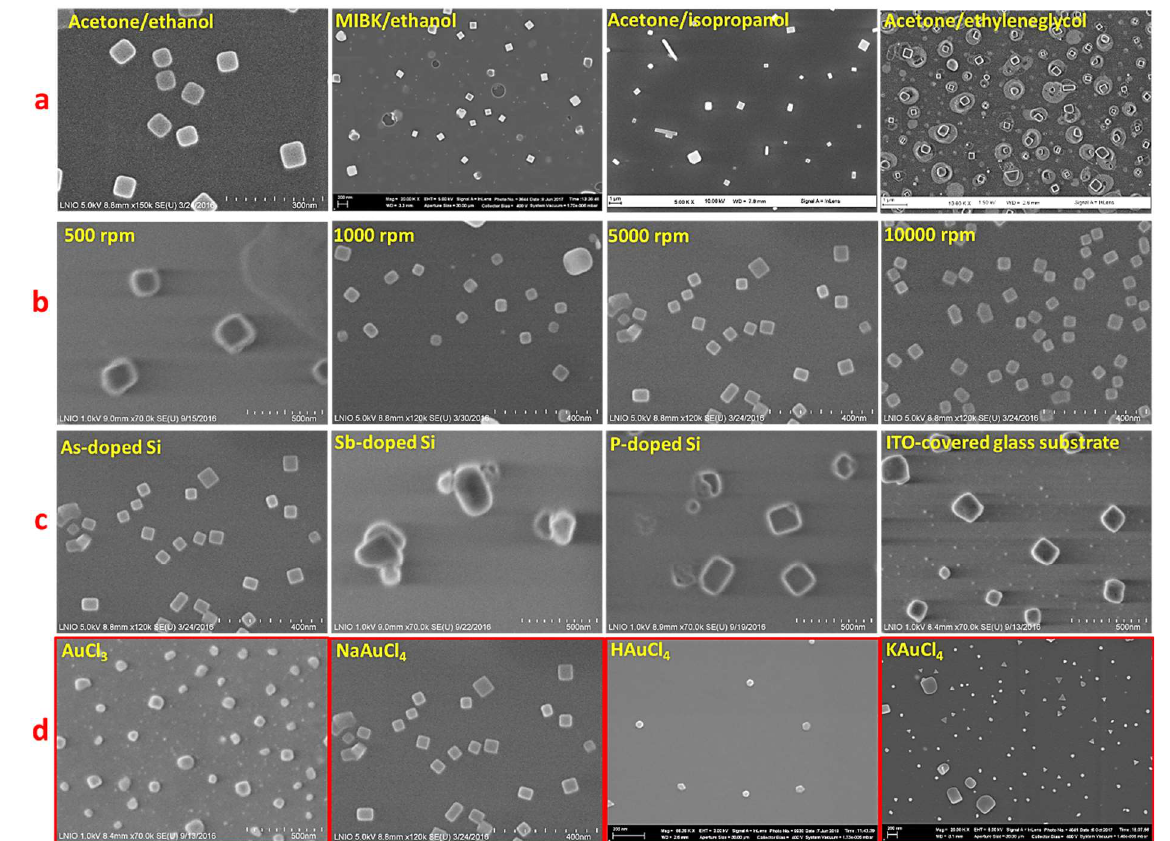
Figure 5. SEM images of GNP obtained under various experimental conditions. ( a ) NaAuCl 4 /PMMA/different solvent couples using 5000 rpm as spin coating speed and As-doped silicon substrate. ( b ) NaAuCl 4 /PMMA/acetone/ethanol using As-doped silicon substrate and various spin coating speeds. ( c ) NaAuCl 4 /PMMA/acetone/ethanol using 5000 rpm as the spin coating speed and various substrate conductivities. ( d ) NaAuCl 4 or HAuCl 4 or KAuCl 4 /PMMA/acetone/ethanol using 5000 rpm as spin coating speed and As-doped silicon substrate.